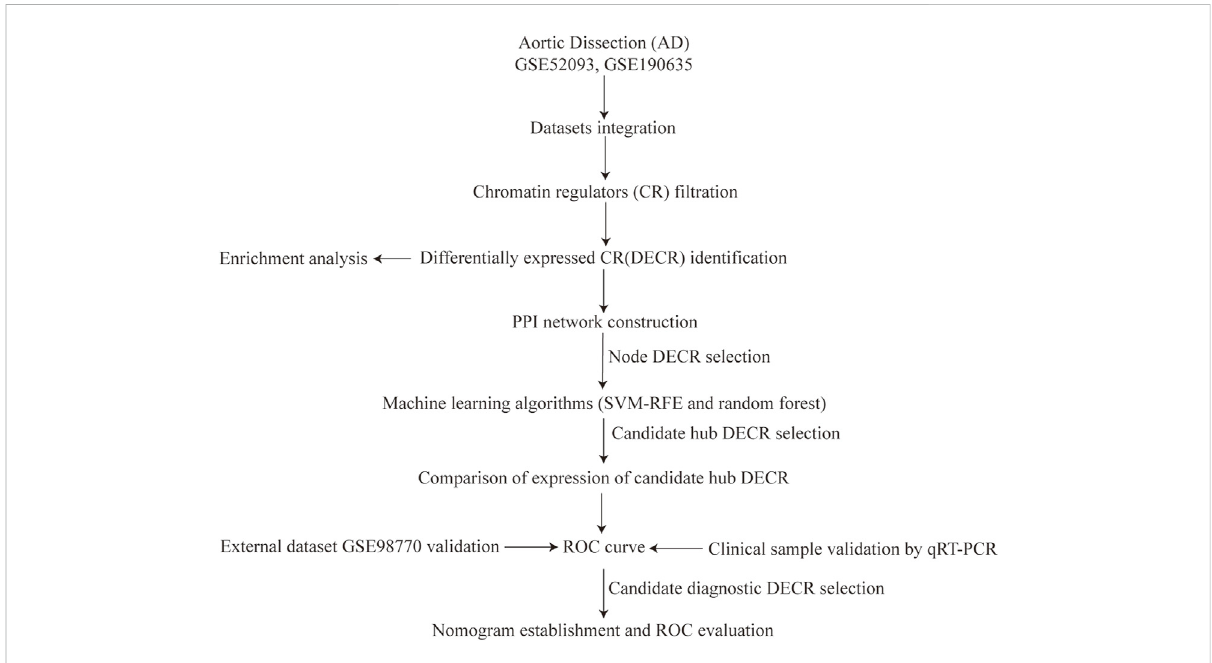
FIGURE 1 Study fl owchart. Abbreviations AD, aortic dissection; CR, chromatin regulators; SVM-RFE, support vector machine-recursive feature elimination; ROC, receiver operating